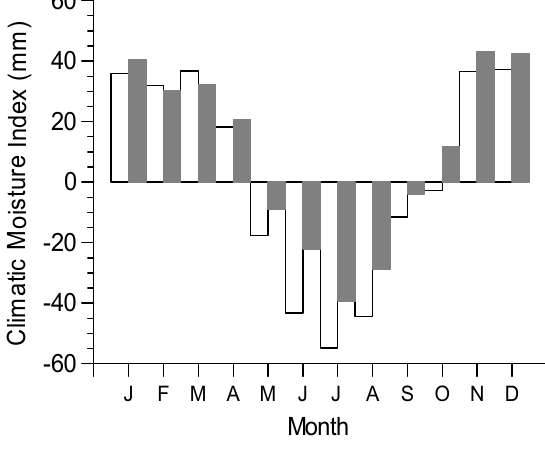
Figure 3. Mean monthly climatic moisture index averaged from 1965–2010 in Mio (open bars) and Hale Loud Dam (gray bars),